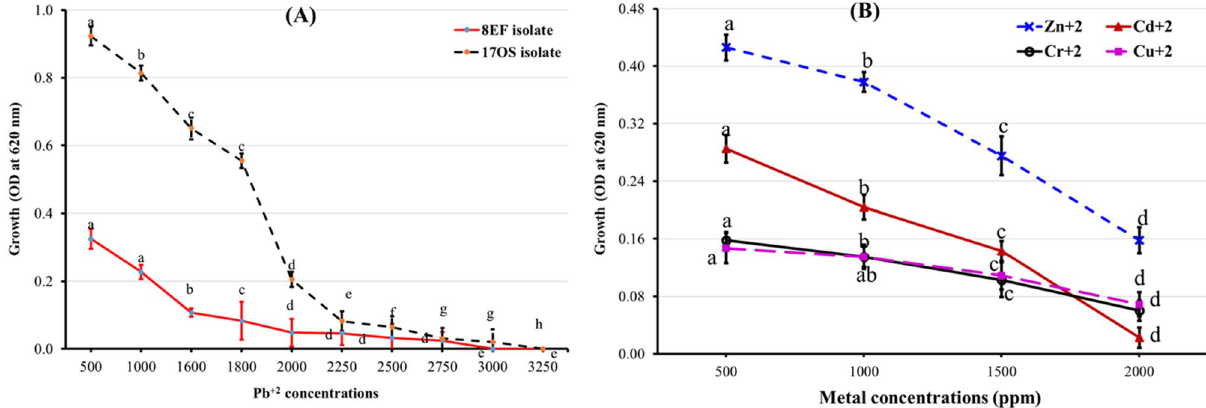
Figure 3. Growth density (O.D) of both 8EF and 17OS isolates as affected by lead concentrations ( A ) and 17OS isolate as influenced by multi-metal (Zn +2 , Cd +2 , Cr +6 , and Cu +2 ) concentrations of ( B ). a,b Values with small letters above the same line having different superscripts are the significant difference (at p ≤ 0.05). Standard deviation